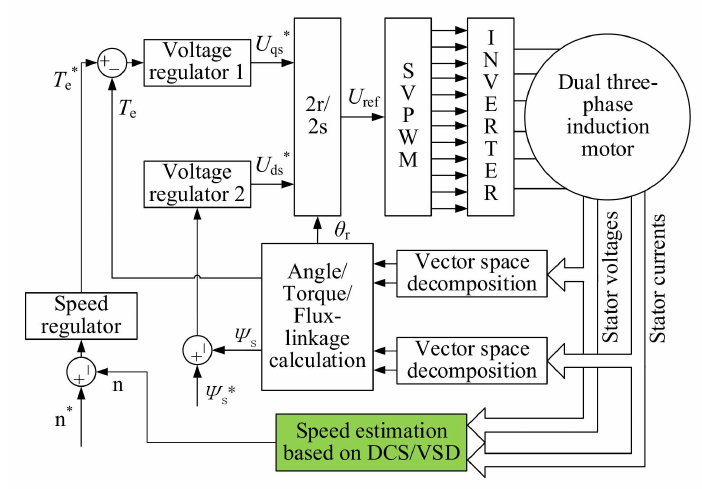
Figure 10. Structure diagram of direct torque control for DTPIM.